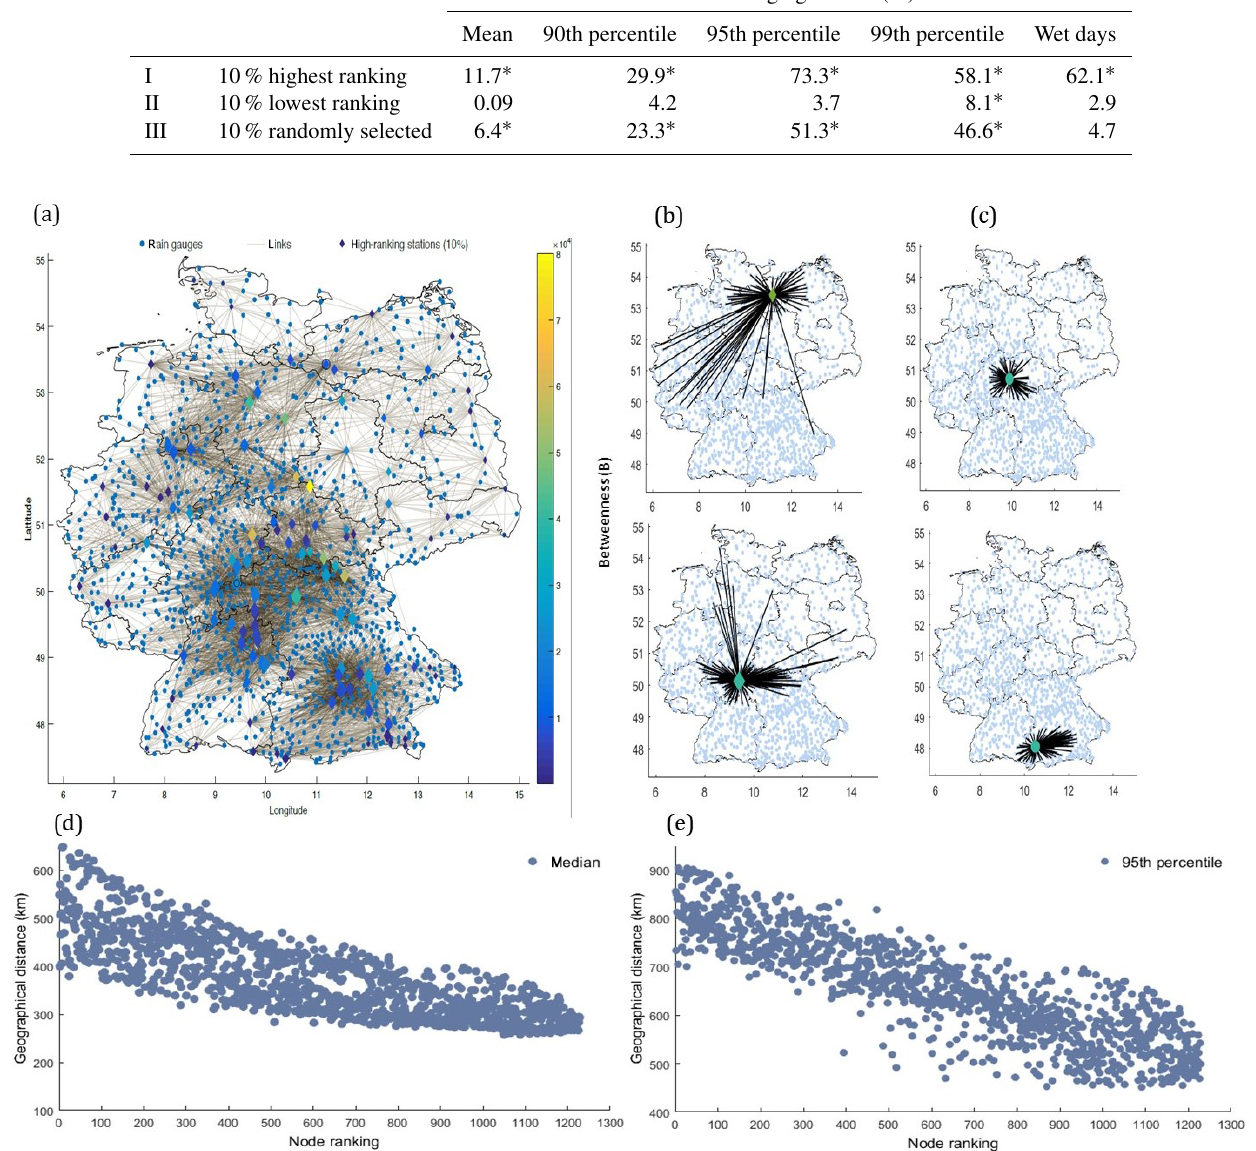
Figure 7. (a) Connections and location of 10% ( ∼ 122) of the highest ranking rain gauges. The size and color of the diamond markers indicate the degree and betweenness centrality of the rain gauges, respectively. Connections corresponding to (b) two high-ranking stations (station IDs 21320 and 16149) and (c) two low-ranking stations (station IDs 26132 and 20356). (d) The median and (e) 95th percentile geographical distance plotted against node